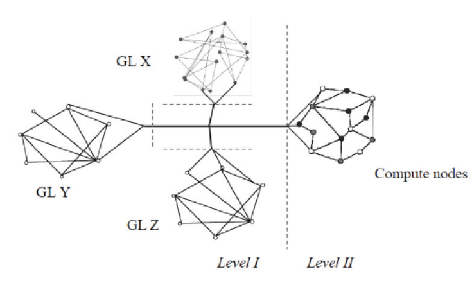
Fig. 4. Bio-inspired Distributed Computing